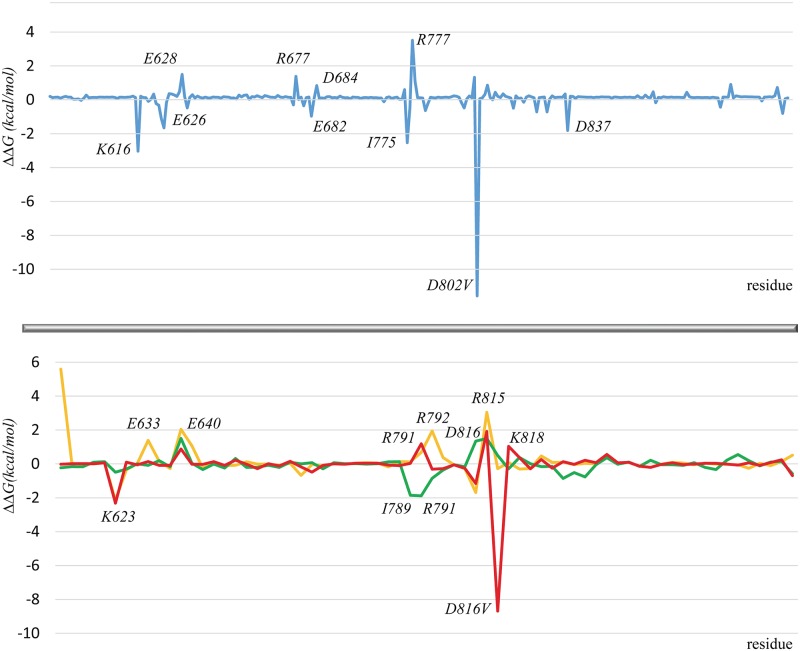
Binding energy of the Imatinib•target complexes.Difference in the per residues contribution to the binding energy (ΔΔG) between the native and mutated targets–(top) CSF-1RWT and CSF-1RD802V(blue), and (bottom) KITWT, KITV560G (orange), KITS628N (green) and KITD816V (red). The labeled residues are characterized by ΔΔG values more than 1 or less than -1 kcal/mol.